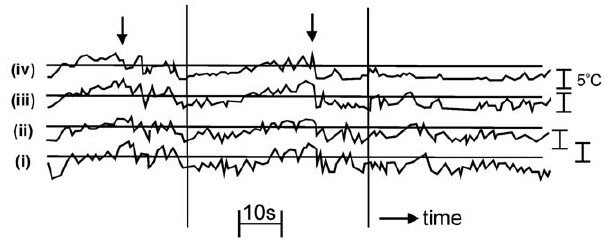
Figure 1. Some typical time traces of the temperature fluctuations in the atmosphere, showing characteristic ramp- like features. The recordings were made by Phong-Anant et al. [14] by the simultaneous use of four temperature probes at heights of (i) 1 m, (ii) 2 m, (iii) 4 m and (iv) 8 m above the ground. The probe at 4 m was 1 m upwind of the others. Using Taylor’s hypothesis (i.e. assuming that turbulence is frozen in time and advected downwind by the mean flow), the time traces are equivalent to taking spatial cuts by a fast- moving probe. Arrows indicate two examples of sharp structures.